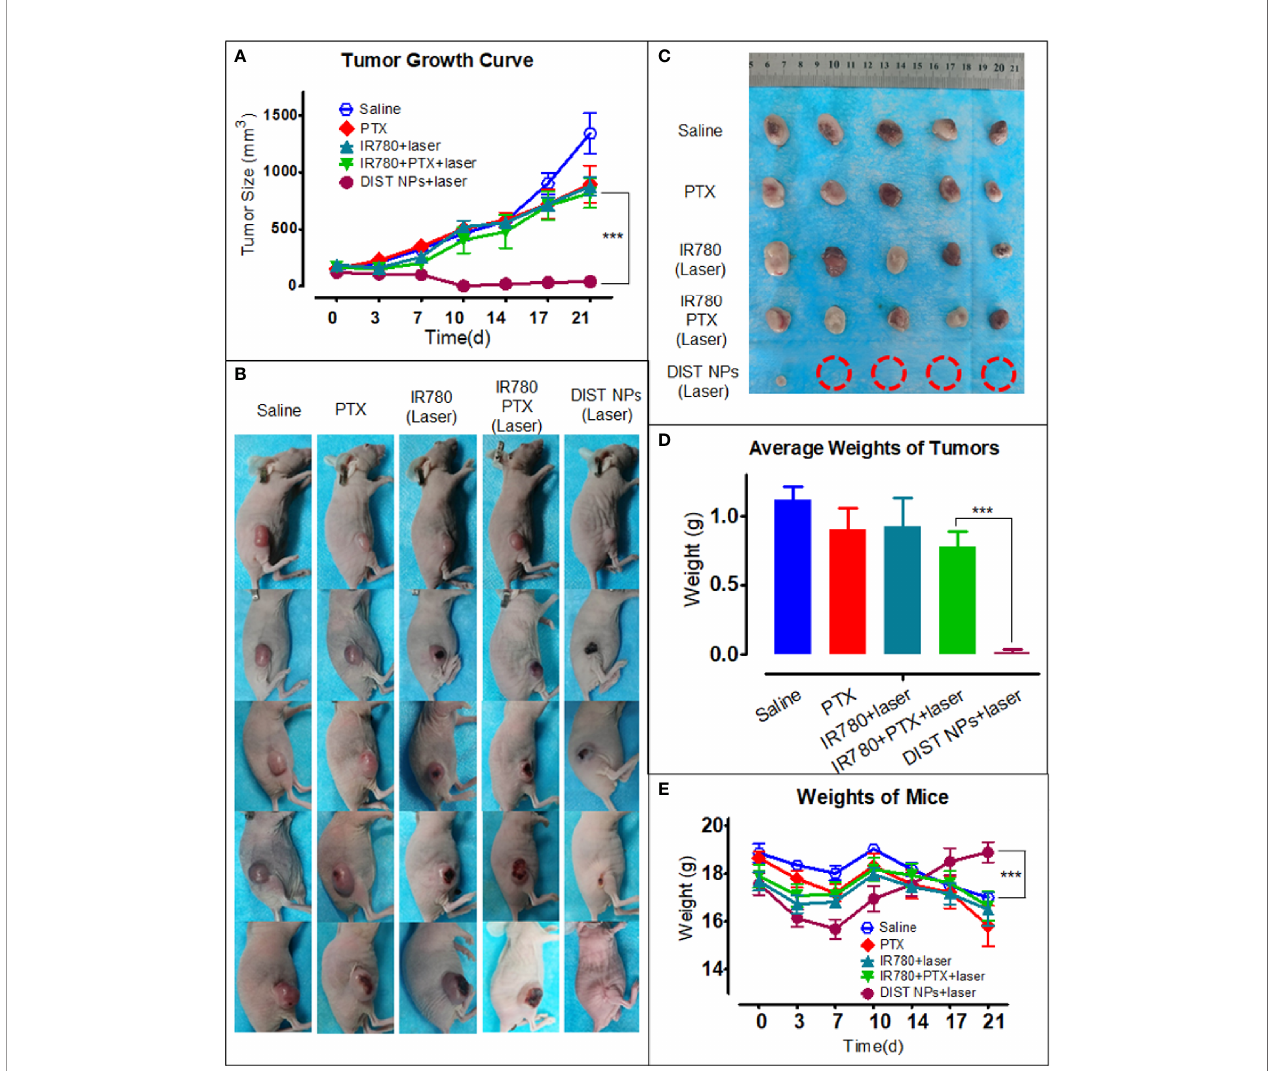
FIGURE 8 | The antitumor effect of the DIST NPs in vivo . The tumor volume growth curve of each group (n = 5) (A) . The photographs of all the mice in the tumor treatment experiment (B) . The photographs of the residual tumors taken out after the treatment. The red circles represent the ablated tumors (C) . The tumor weighing results (n = 5) (D) . The mean weight changing curve of the mice in the experiment (n = 5) (E) . The *** represents p <